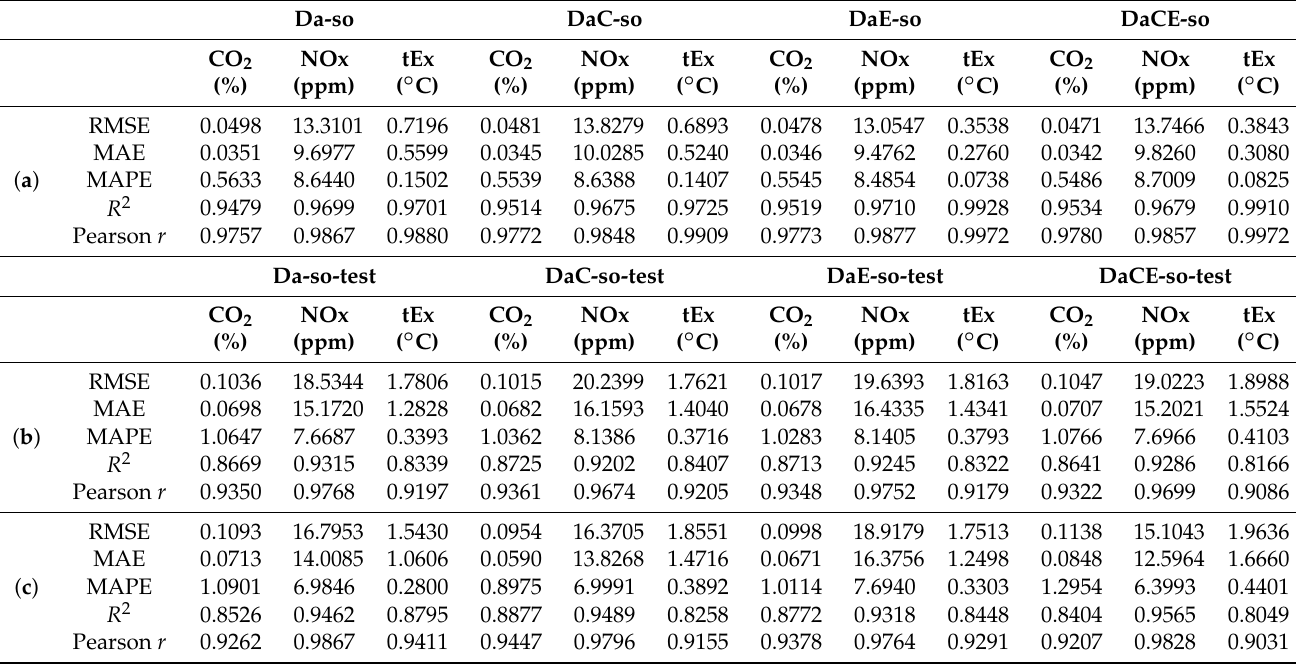
Table 10. Metrics from different datasets for the ANN model with the SCR mode: ( a ) trained 15 times from the ATC training set with average taken of the 15 metrics from the validation set; ( b ) 15 trained models tested from BTC with average taken of the 15 metrics; ( c ) the best model for the validation set tested from BTC and its metrics.